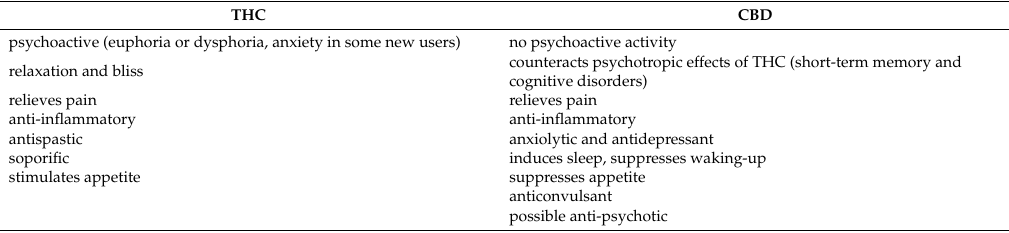
Table 1. The differences in clinical effects of tetrahydrocannabinol (THC) and cannabidiol (CBD).